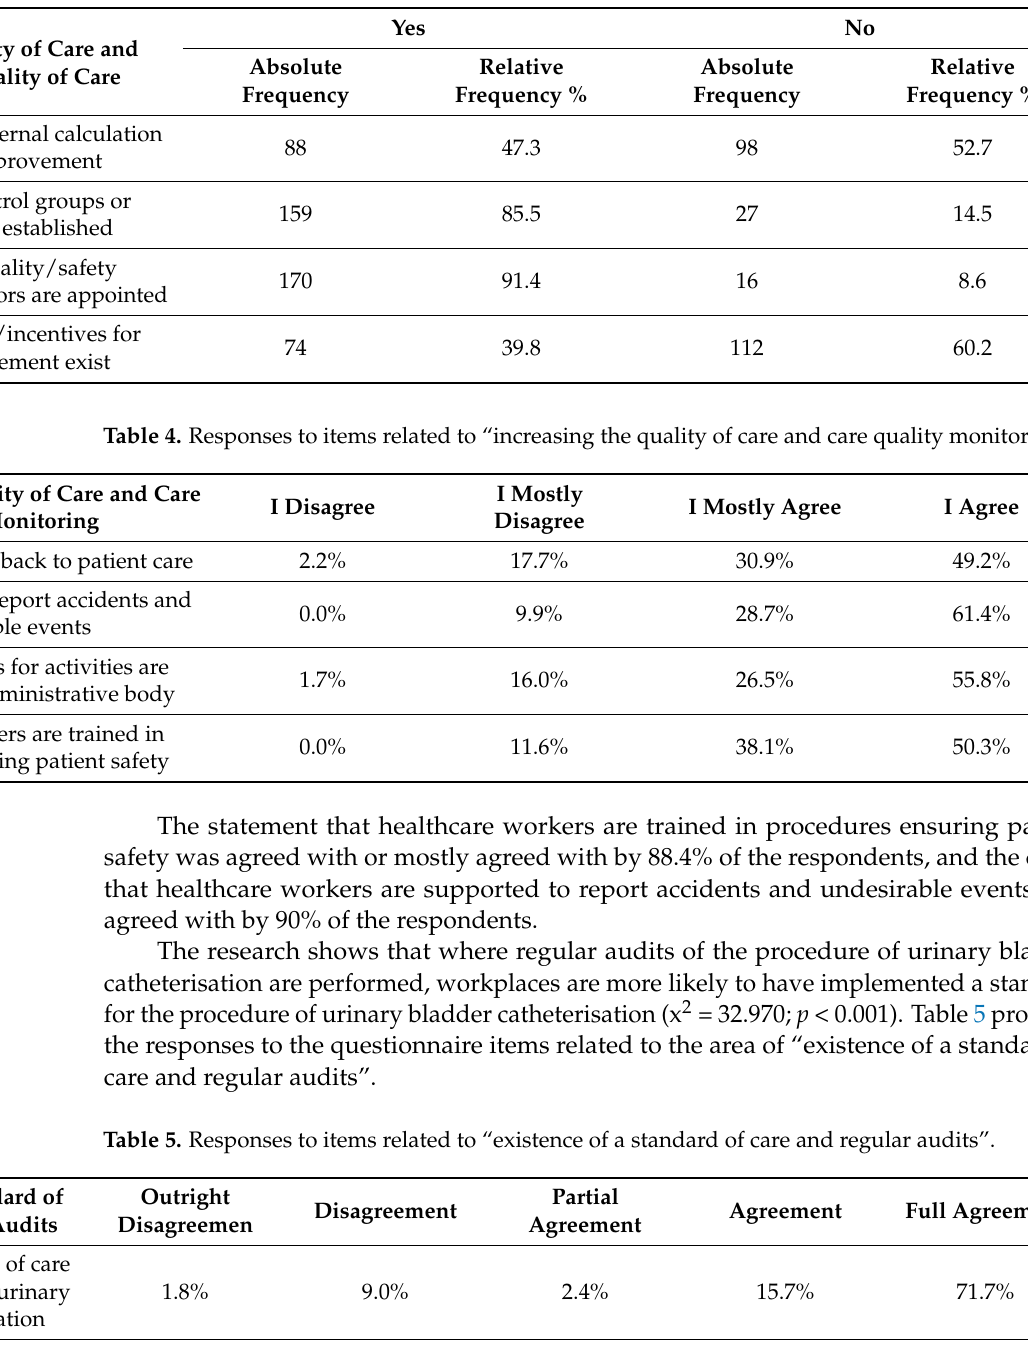
Table 3. Responses to items related to “improving the quality of care and care quality monitoring”.